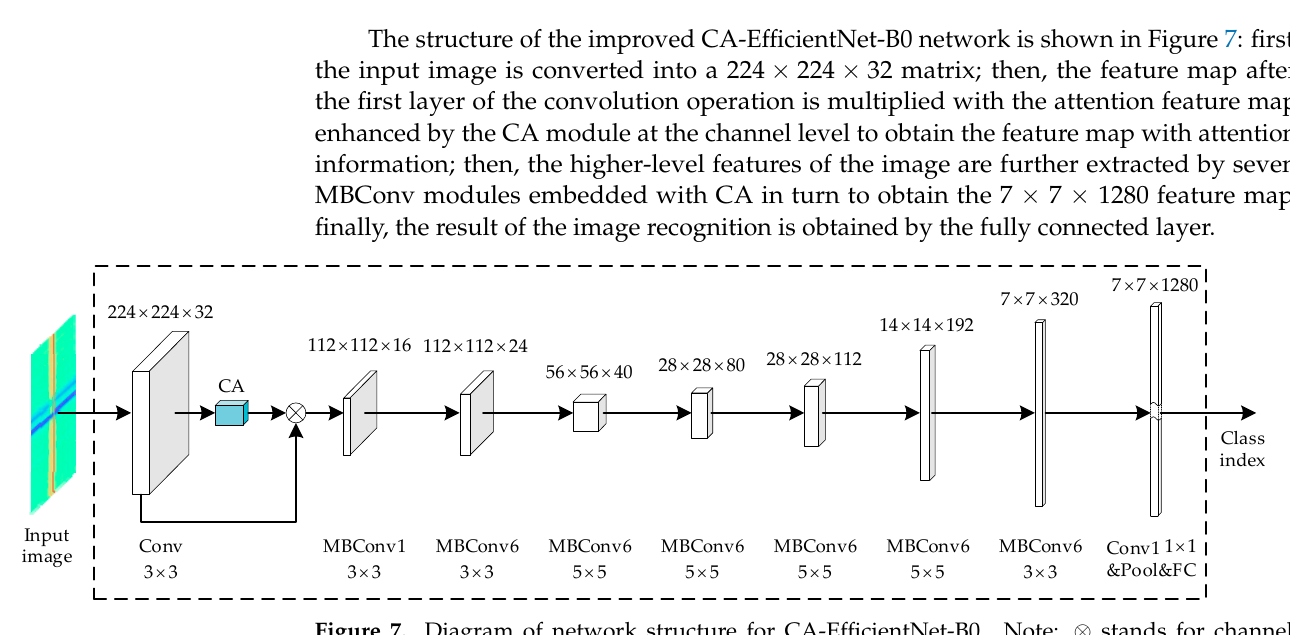
Figure 7. Diagram of network structure for CA-EfficientNet-B0. Note: ⊗ stands for channel- level multiplication.